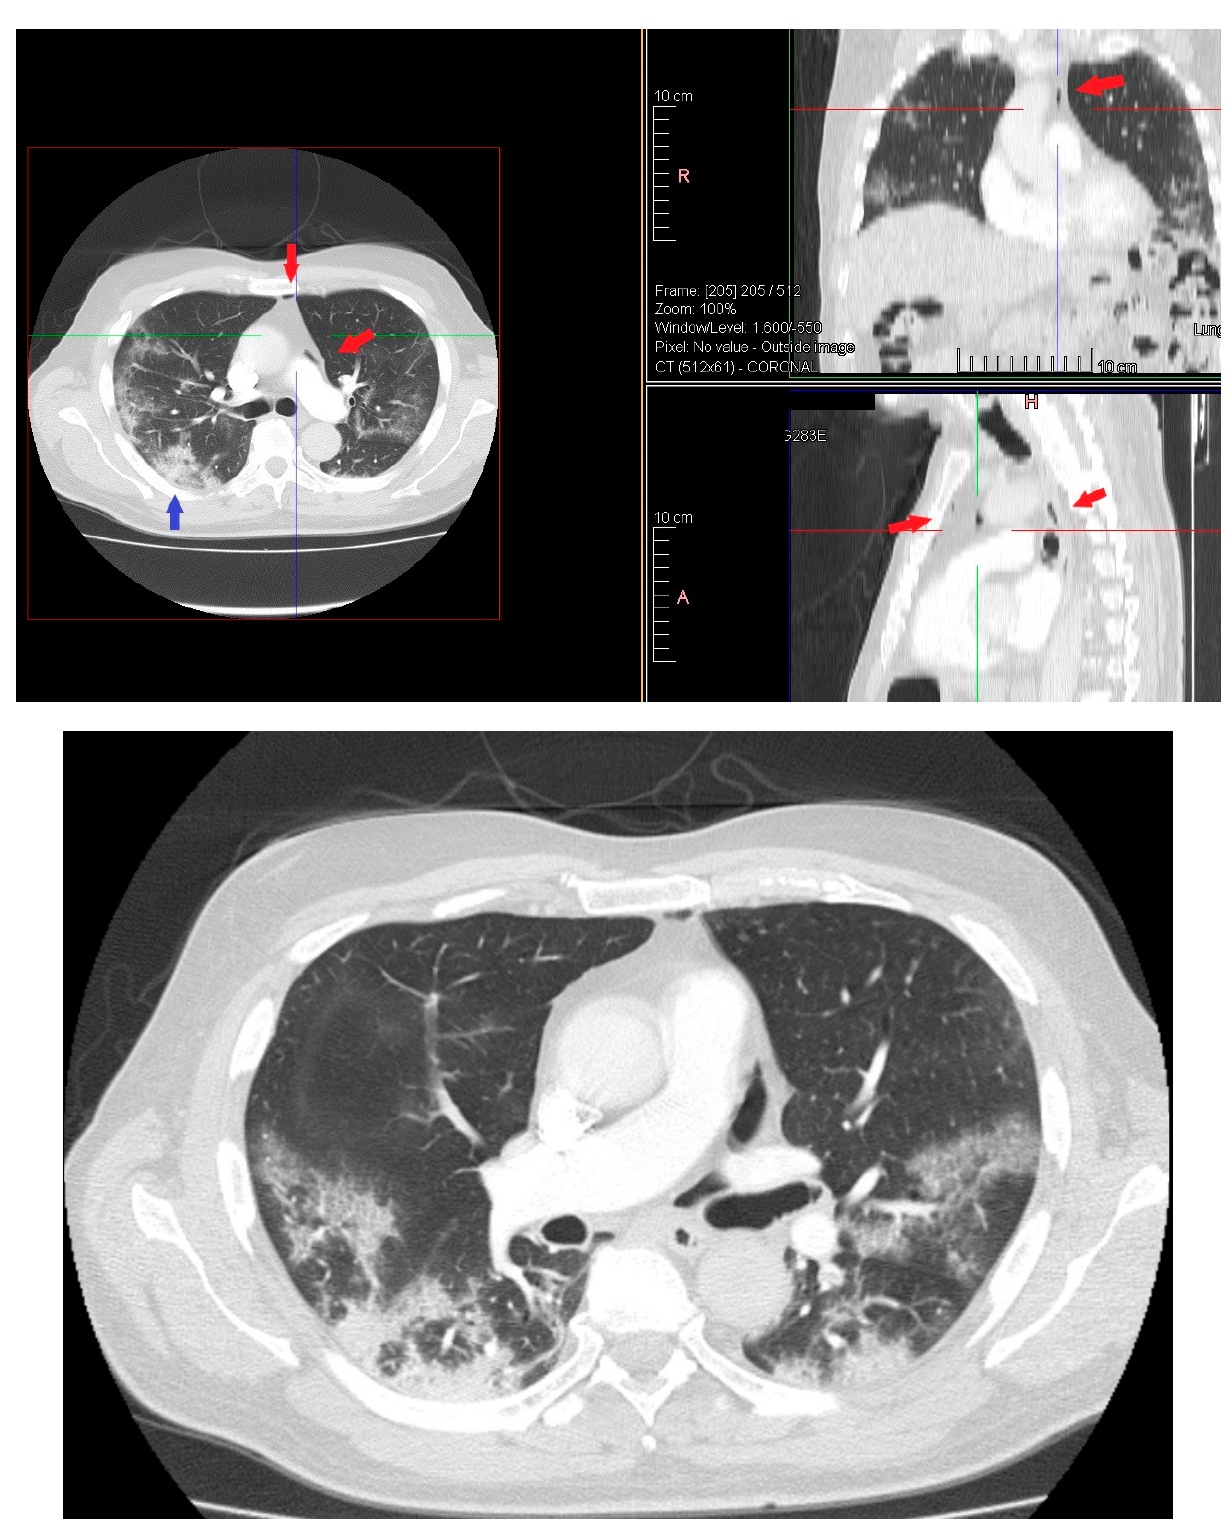
Figure 2. ( A ) EKG performed on admission. ( B ) EKG performed when pneumopericardium was discovered.